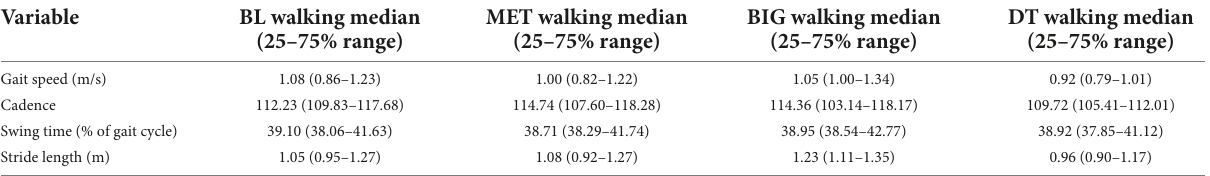
TABLE 2 Median and interquartile range of spatiotemporal gait variables.